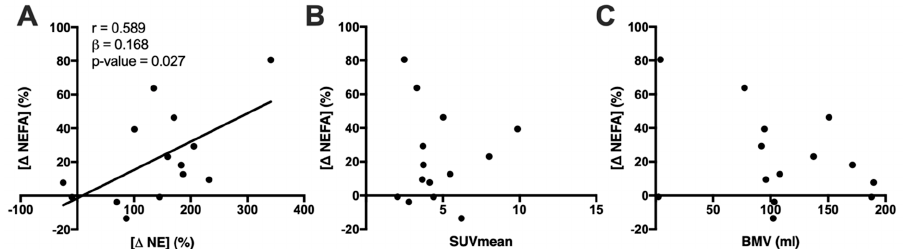
Figure 1. Correlation of the change in total plasma non-esterified fatty acid (NEFA) concentration after 90 min mild cold exposure against ( A ) peak norepinephrine (NE) concentration change and ( B) brown adipose tissue (BAT) activity (SUVmean; ( C ) BAT metabolic volume (BMV). Pearson’s r value ( n = 14) is shown for significant correlations ( p <